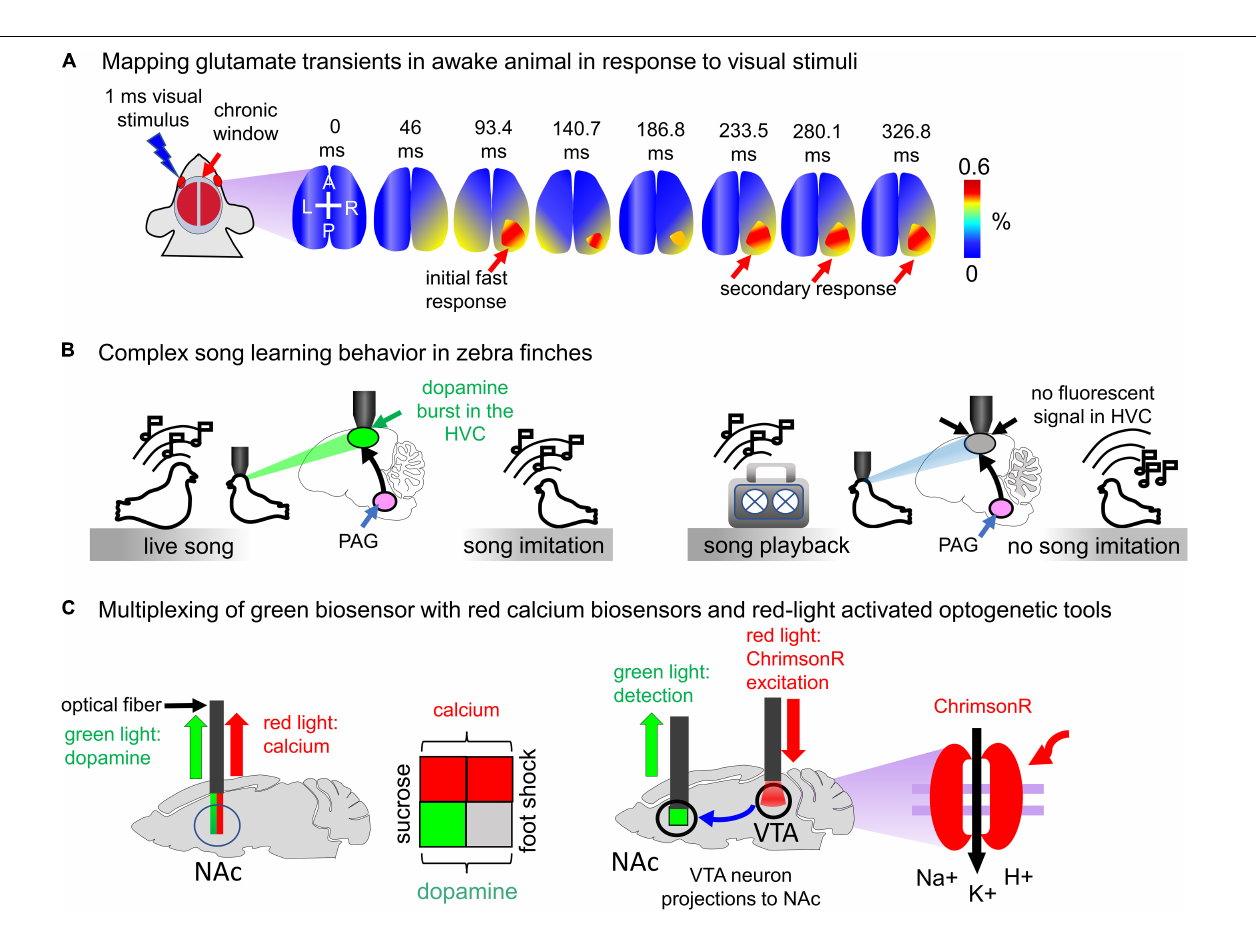
FIGURE 6 | Visualization of neurotransmitter transients in vivo . (A) Mapping glutamate transients in the mouse brain is performed through the chronic cranial window. One millisecond light visual stimulation induces an initial fast response followed by a clearly separated secondary response in awake Emx-CaMKII-iGluSnFR mouse (Xie et al., 2016). (B) Complex song learning in zebra finches is outlined. Left: juvenile zebra finch is exposed to the living adult male tutor. The song causes dopamine bursts in the high vocal center (HVC) of the juvenile bird, resulting in song learning. Right: juvenile zebra finch is exposed to the playback of the song. Dopamine bursts in the HVC of juvenile bird are not detected, and consequently, song learning does not occur (Tanaka et al., 2018). (C) Spectral multiplexing of green fluorescent dLight1.1 with either red fluorescent jRGECO1a biosensor or channelrhodopsin ChrimsonR activatable with red light. Left: both dopamine and calcium signals are detected in the mouse brain using multicolor fiber photometry. The sucrose application causes both dopamine transients and neuronal activity in the NAc (green and red squares), whereas the foot shock increases calcium but not dopamine transients (gray and red squares). Right: ChrimsonR channelrhodopsin is selectively expressed in the VTA of the mouse brain. Activation of ChrimsonR with red light causes the dopamine release in the NAc. The VTA neuron projections to NAc are shown with the